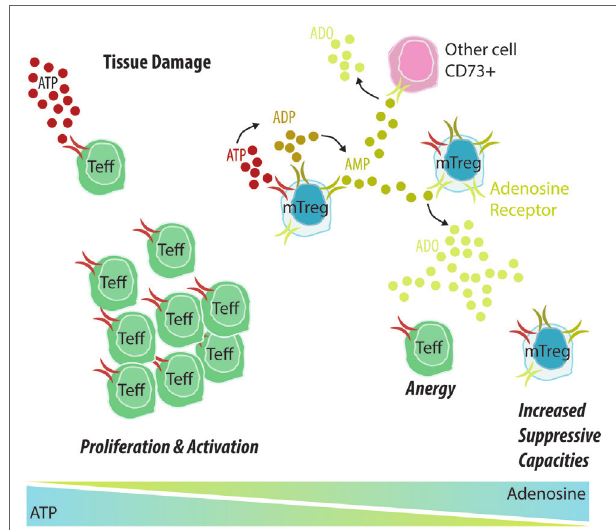
FiGURe 2 | Memory Treg (mTreg) cells induce the degradation of ATP into adenosine, promoting a tolerant environment. (1) An allograft undergoes constant attacks from the immune system, causing tissue damage that leads to the release of ATP into the extracellular environment. (2) In the context of allograft dysfunction, ATP will bind to CD39 expressed by Teff cells, leading to their activation and proliferation and potentiating the inflammatory environment. (3) In tolerant patients, ATP will mostly bind to CD39 expressed by mTreg cells and be further degraded into ADP and AMP by CD39 and into adenosine by CD73. An adenosine-rich environment will promote Teff anergy and increase the suppressive capacity of mTreg